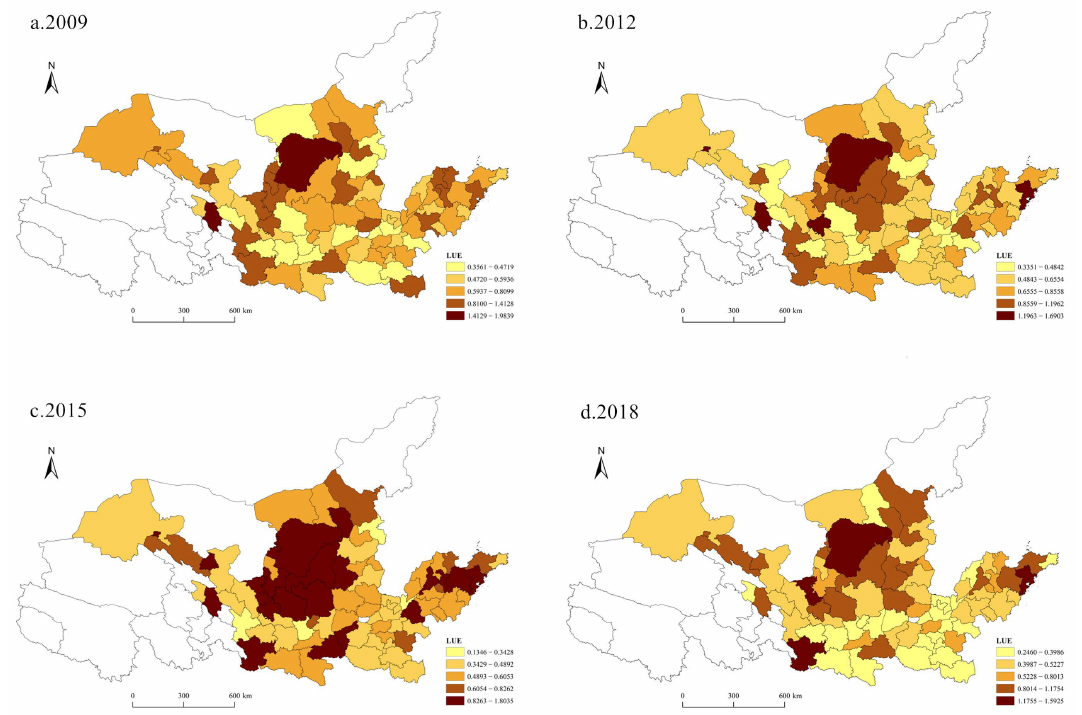
Figure 6. Spatial evolution of LUE in the Yellow River Basin from 2009 to 2018.